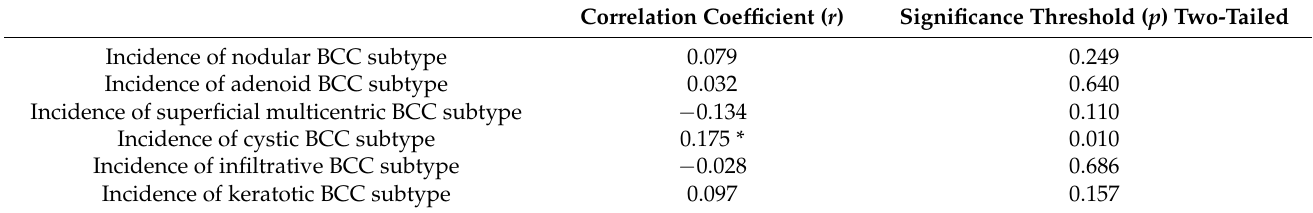
Table 7. Correlation of the age of the subjects with the diagnostic incidence with the six histopatho- logical BCC subtypes.